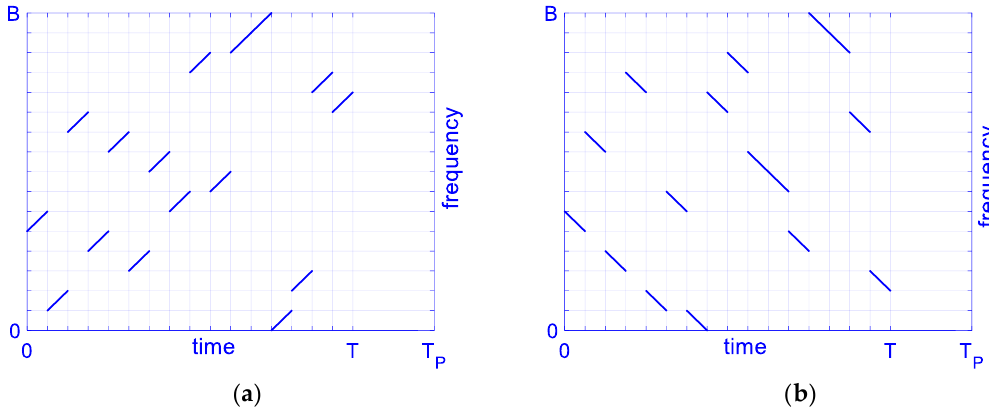
Figure 1. Time-frequency structure of conventional orthogonal frequency division multiplexing (OFDM) chirp waveform, M = 16. ( a ) s 1 ( t ) ; ( b ) s 2 ( t ) .